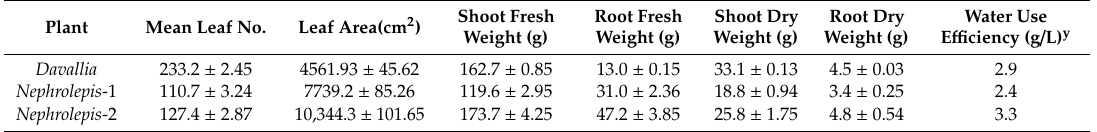
Table 1. Plant growth parameters measured at harvest by species. They were harvested once their common commercial canopy sizes were attained z .